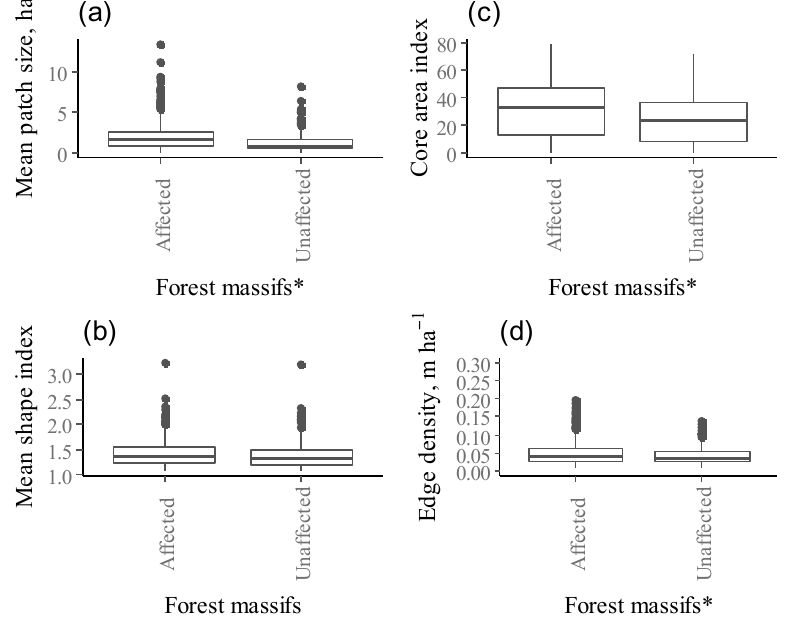
Figure 3. Mean landscape metrics (( a ) mean patch size, ( b ) core area index, ( c ) mean shape index, ( d ) edge density) for selected Norway spruce stands (we combined both damaged and control stands in affected forest massifs) between the affected and unaffected forest massifs (* indicate significant difference using Kruskal-Wallis test; overall significance level = 0.05).